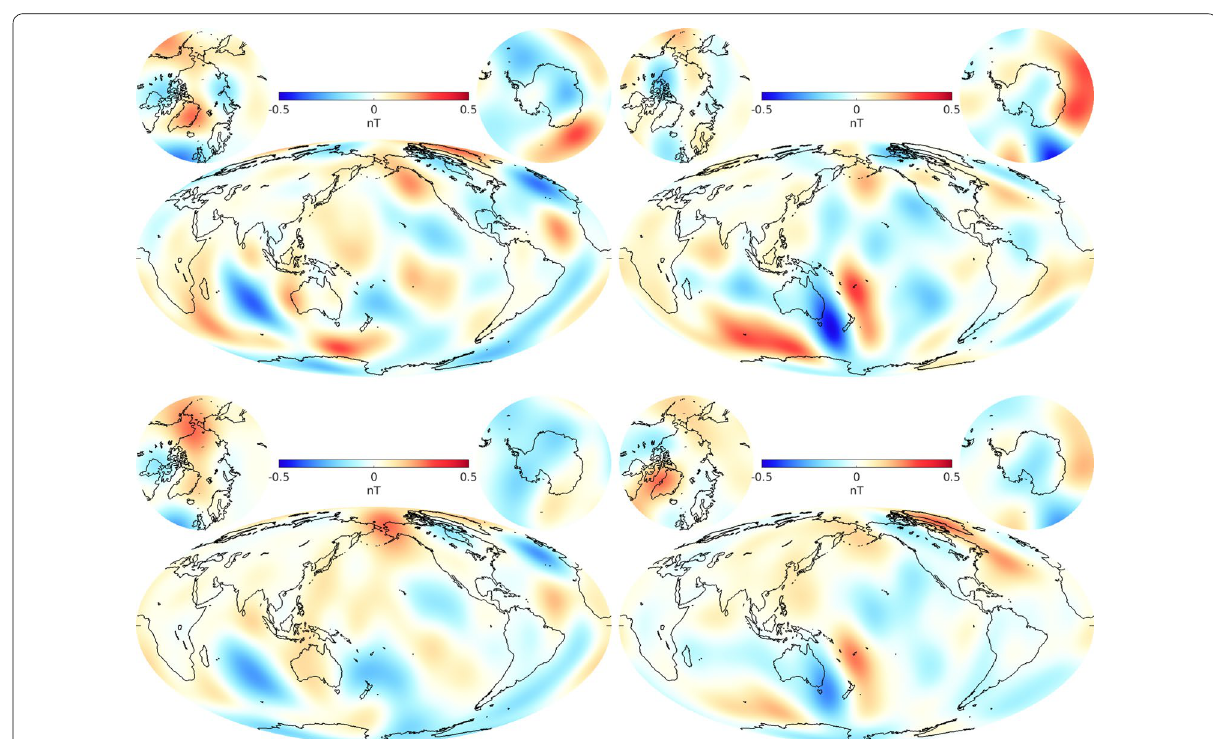
1 12 at satellite = −